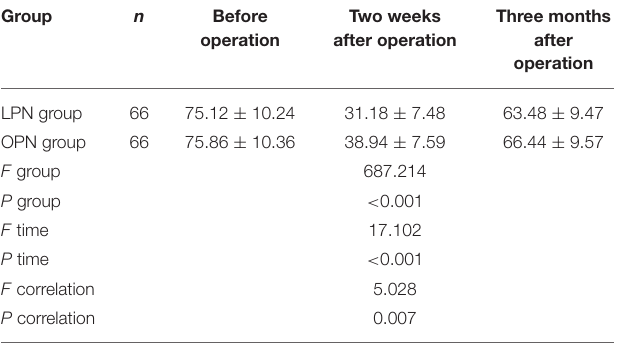
TABLE 3 | Comparison of eGFR levels [ x ± s, ml/(min · 1. 73 m 2 )].